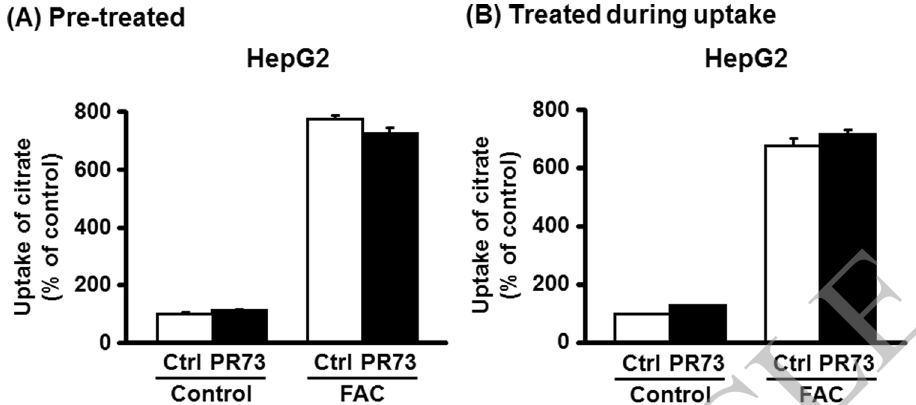
Figure 6. Influence of hepcidin mimetic minipeptide (PR73) on citrate uptake in FAC-treated HepG2 cells. HepG2 cells were cultured in the absence or presence of FAC (250 μ g/ml) for two passages. ( A ) Prior to seeding of the cells for uptake measurements, the cells were treated with or without PR73 (1 μ M) for 24 h. The cells were then prepared for uptake measurements. Uptake of [ 14 C]-citrate (3.5 μ M) was measured in a NaCl buffer, pH 7.5 for 15 min. ( B ) Control and FAC-treated cells were also used citrate uptake without pretreatment in the presence of PR73, but uptake was measured with PR73 present in the uptake medium during the measurement of citrate uptake.